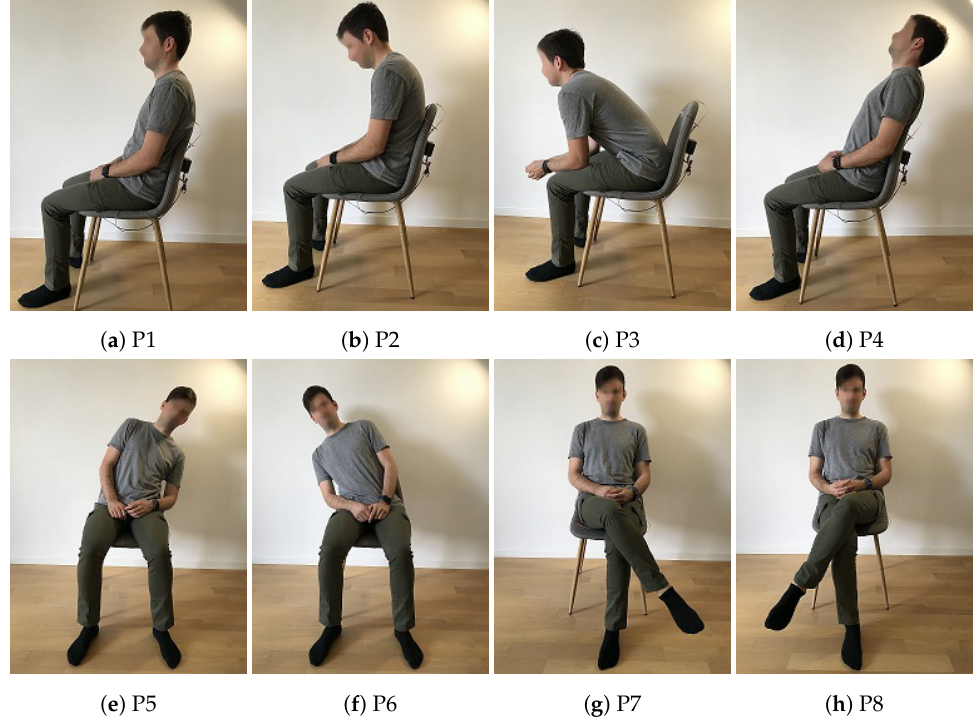
Figure 5. The eight sitting postures: ( a ) P1: upright; ( b ) P2: slouching; ( c ) P3: bending forward; ( d ) P4: bending backwards; ( e ) P5: bending left; ( f ) P6: bending right; ( g ) P7: right leg above; ( h ) P8: left leg